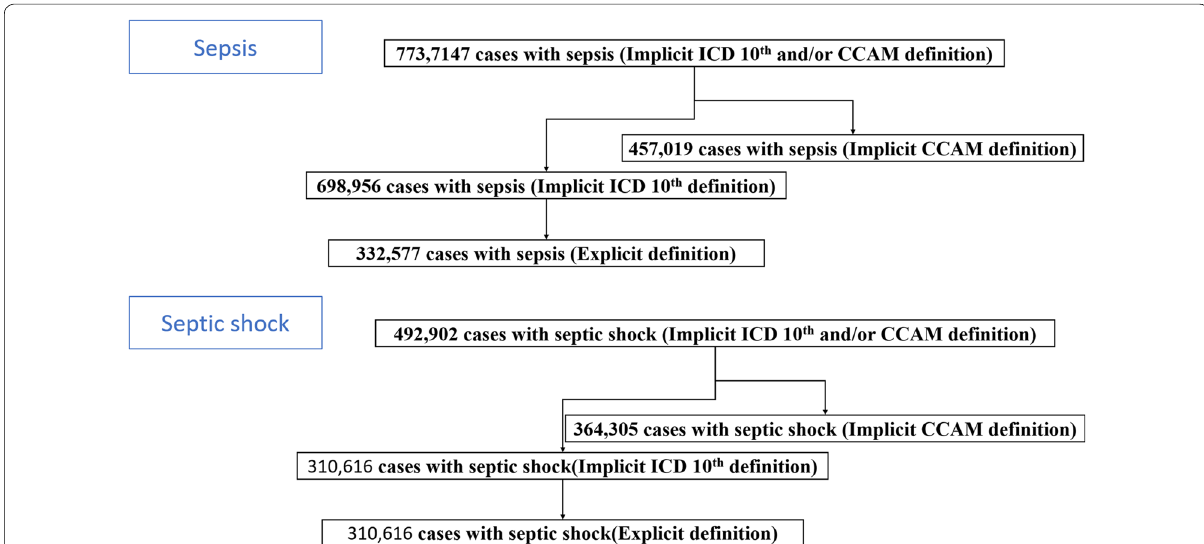
Fig. 1 ICD‑10: International Statistical Classification of Diseases, 10th Edition. CCAM: “classification commune des actes médicaux”. Implicit definition of sepsis: a code for infection using ICD‑10 and a code for organ failure and/or a procedure code for the use of organ failure supplementation (using ICD‑10 and/or CCAM). Explicit definition of sepsis: ICD‑10 codes including R651 or R572 or R578 or R579. Implicit definition of septic shock: a code for infection using ICD‑10 and a code for shock and/or a procedure code for the use of vasopressor (using ICD‑10 and/or CCAM). Explicit definition of septic shock: ICD‑10 codes including R572 or R578 or